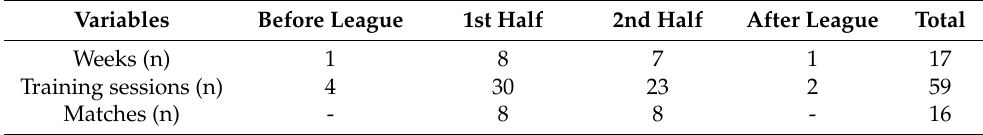
Table 1. Matches and training sessions during the